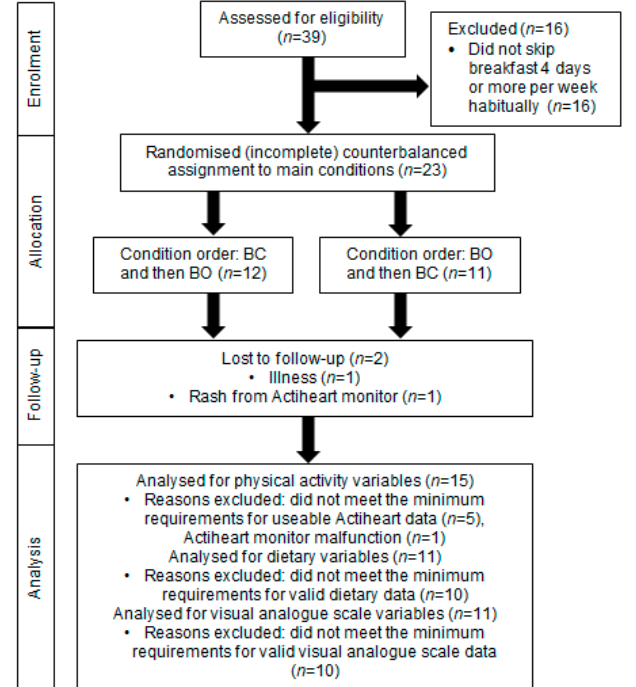
Figure 1. Schematic representation of recruitment, enrolment, and follow-up of adolescent girls who participated in the randomised crossover trial comparing seven days of daily breakfast consumption (BC) with seven days of breakfast omission (BO). BC was the consumption of a standardised breakfast with an energy content equivalent to 25% of individual resting metabolic rate before 09:00 for seven consecutive days; BO was the abstinence from all energy-providing nutrients until at least 10:30 for seven consecutive days. Table 1. Characteristics of adolescent girls who participated in the randomised crossover trial comparing seven days of daily breakfast consumption (BC) with seven days of breakfast omission (BO) 1